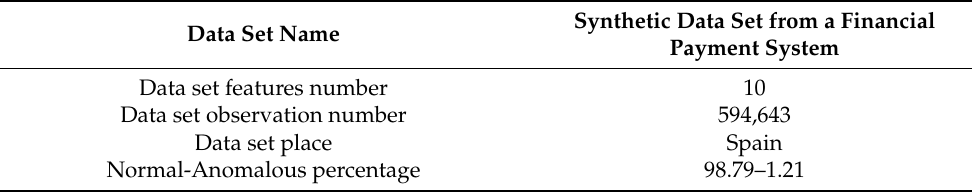
Table 1. Overview of BankSim’s data.